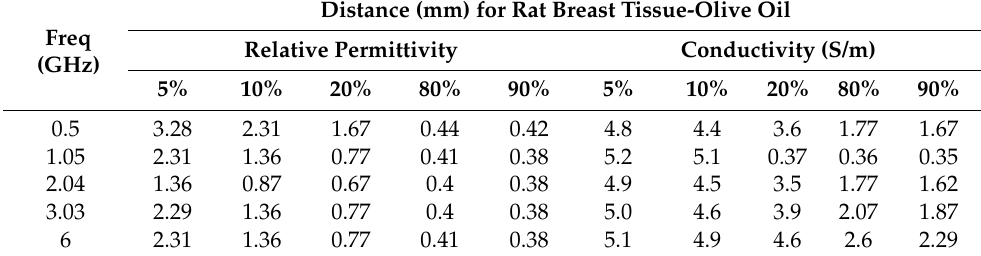
Table 5. Specified increase levels for retrieved relative permittivity and conductivity of double- layered rat breast tissue and olive oil configuration and the corresponding distances (D n ) at 0.5, 1.05, 2.04, 3.03 and 6 GHz frequency points.